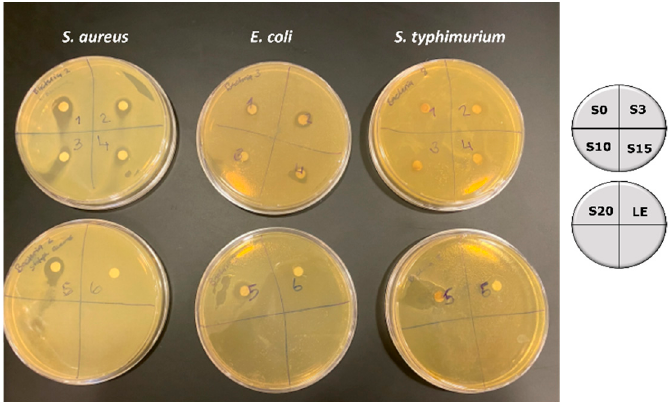
Figure 9. Images of inhibition zones against clinical pathogens by AgNPs.